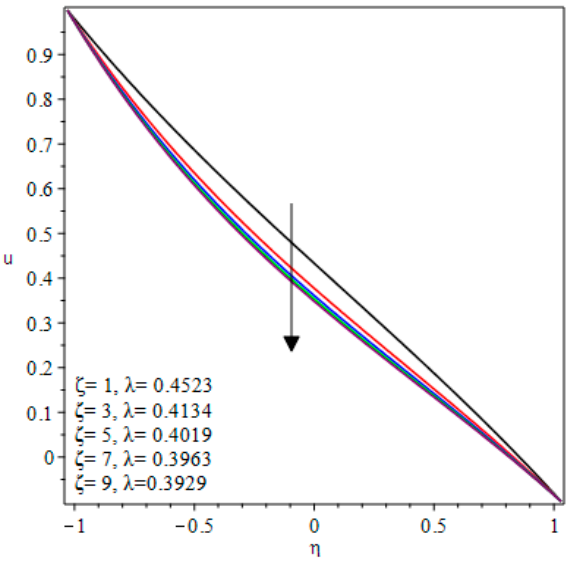
ζ influence on the velocity profile at